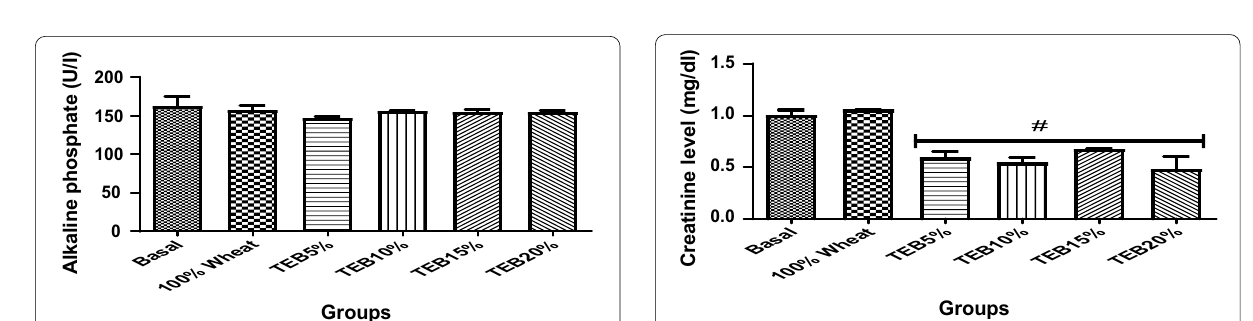
Fig. 7 Effect of enzymatic tacca–wheat biscuit on albino Wistar rats by alkaline phosphate (ALP). 100% Wheat: Rats fed with 100% wheat flour biscuit, TEB5%: Rats fed with 5% enzymatic tacca flour wheat flour biscuit, TEB10%: Rats fed with 10% enzymatic tacca flour 90% wheat flour biscuit, TEB15%: Rats fed with 15% enzymatic + tacca flour 85% wheat flour biscuit, TEB20%: Rats fed with 20% + enzymatic tacca flour 80% wheat flour biscuit +